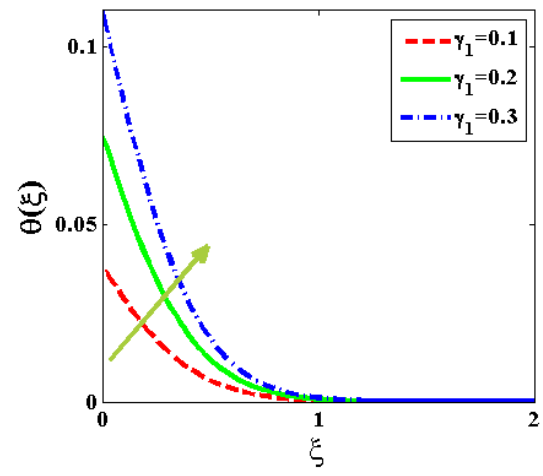
Figure 15. Outlines of θ at diverse quantities of γ 1 .